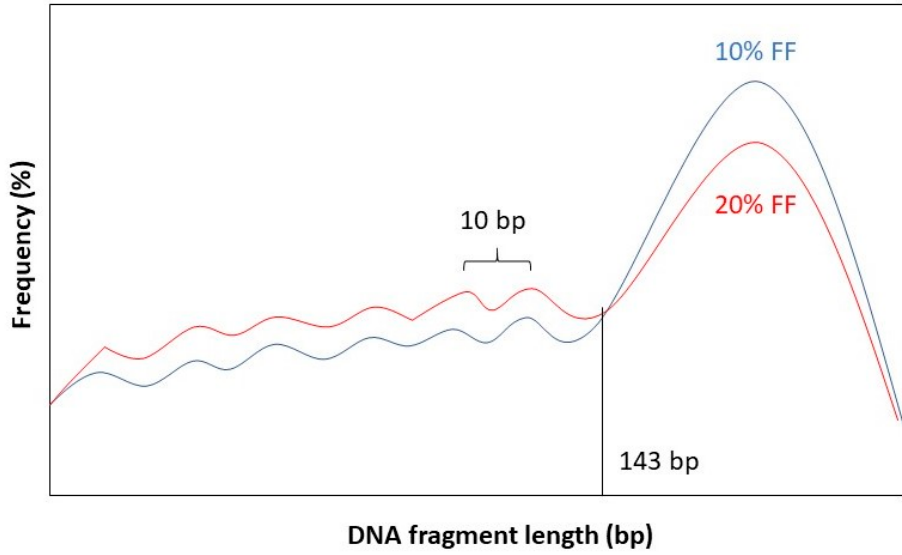
Figure 2. Length distribution of fetal DNA fragments according to different values of the FF: 10% (blue) and 20% (red).